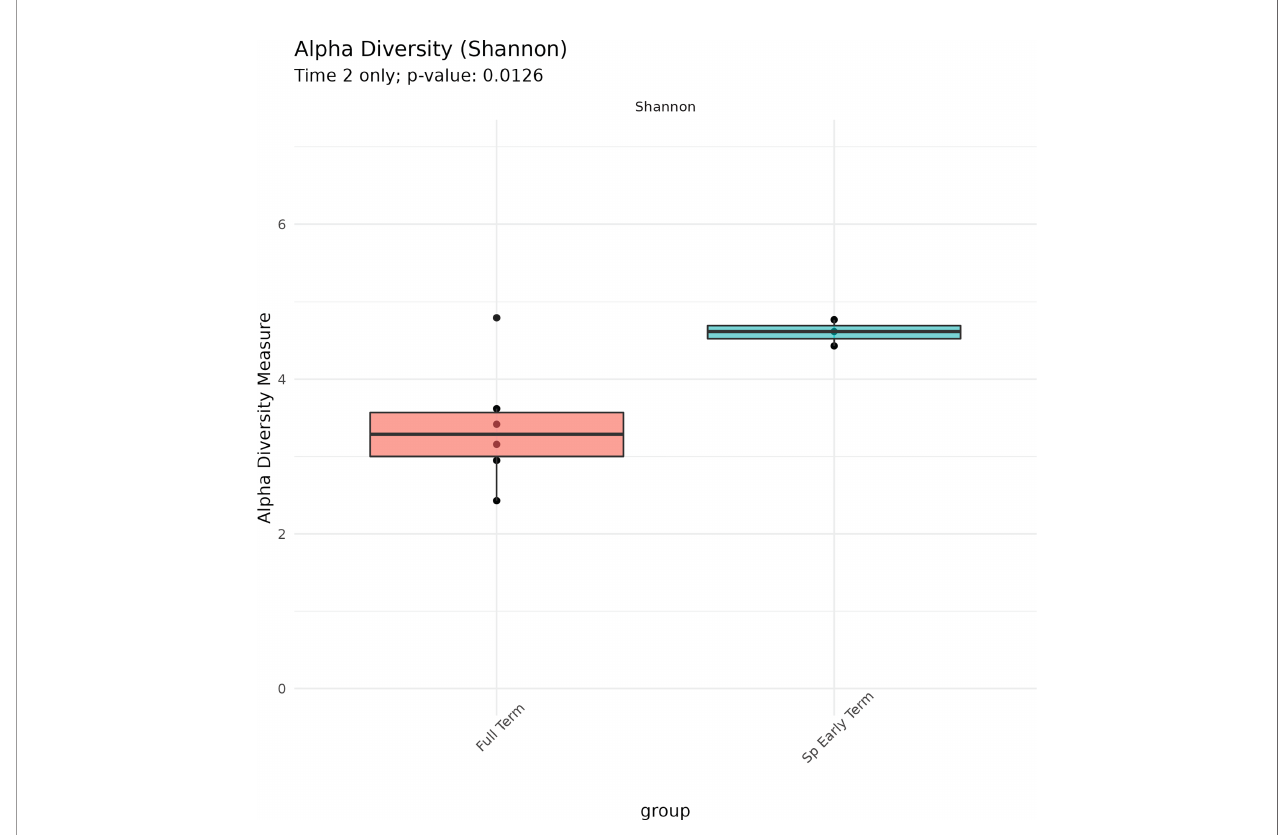
FIGURE 2 | Alpha diversity of subgingival microbiome at Time 2 according to delivery time